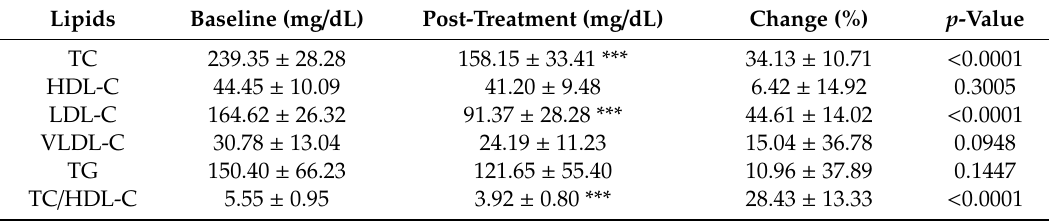
Table 2. Serum lipid levels at baseline and after treatment with atorvastatin (20 mg / day / 4 weeks).